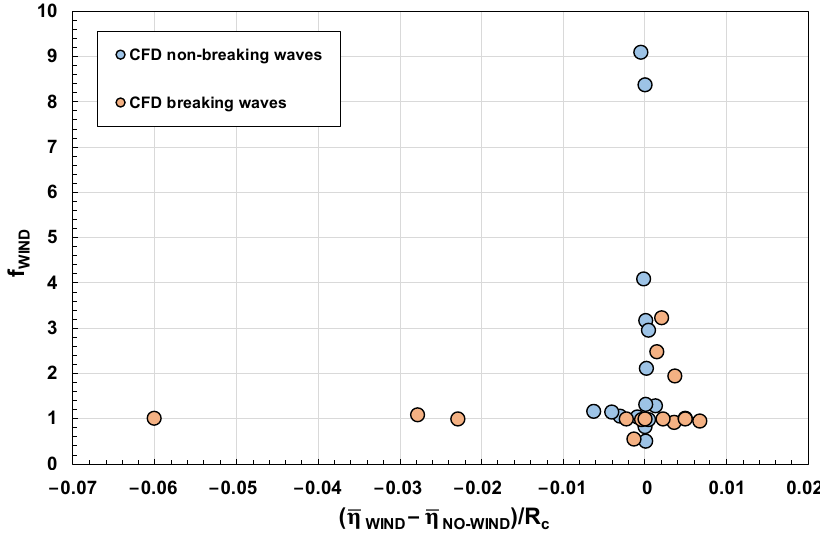
Figure 18. CFD wind factors in function of the ratio between the variation in 𝜂̅ due to the wind and the crest freeboard.